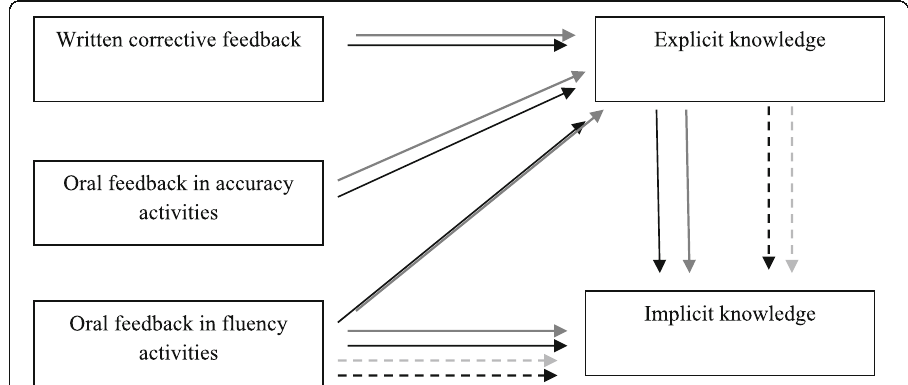
Fig. 1 Potential contributions of oral and written corrective feedback to explicit and implicit